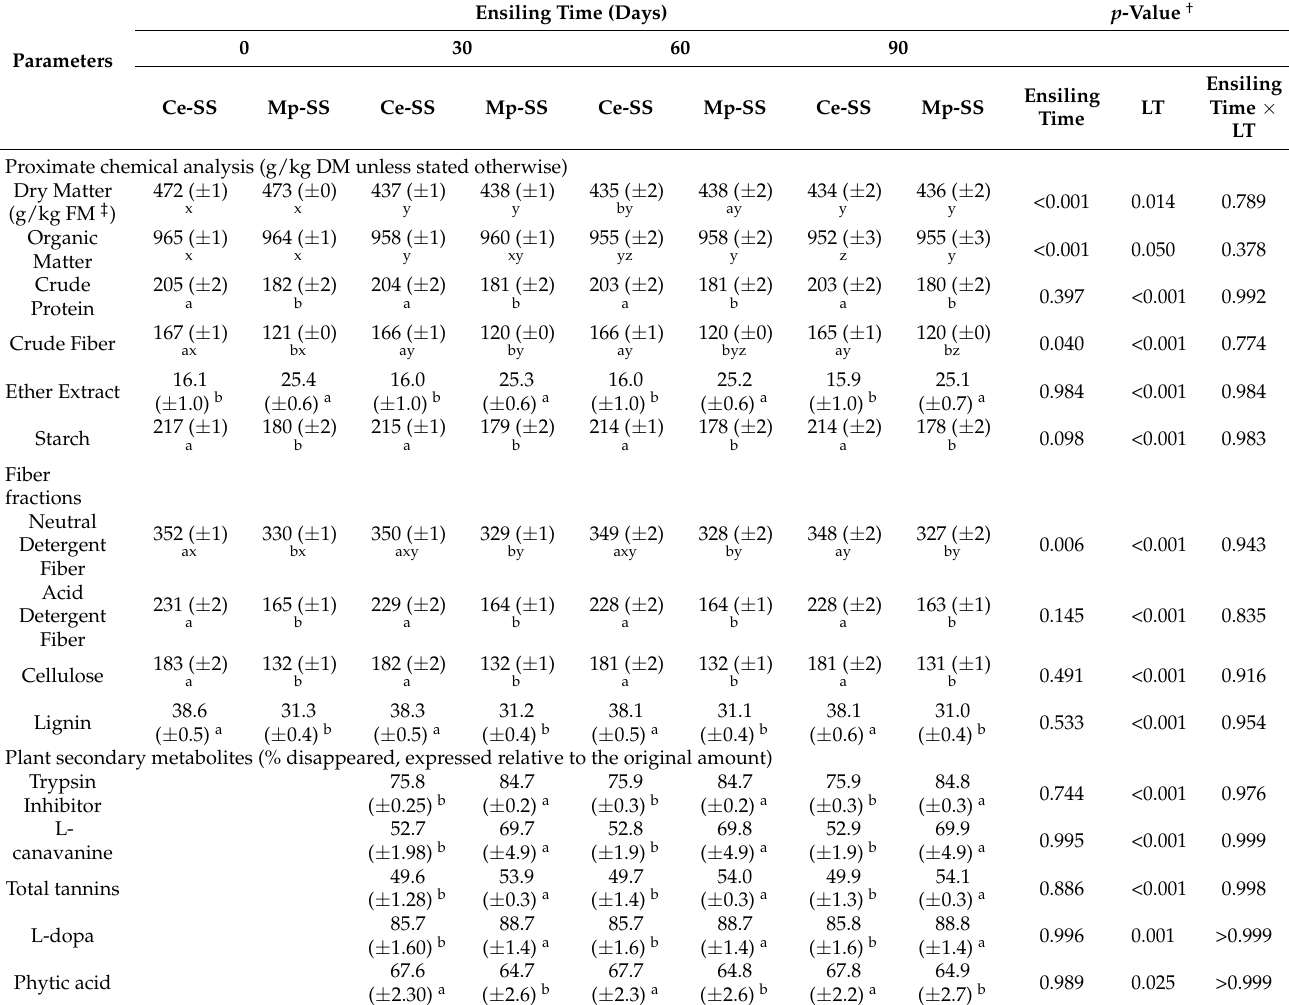
Means with different superscript ( a,b ) in the same row show statistical differences between the tropical legume inside of each ensiling time to p < 0.05 [35]. Different superscripts ( x,y,z ) in the same row and within each tropical legume indicate significant differences ( p < 0.05) according to Tukey [35]. † refers to the statistical significance according to the general linear model of SPSS [34]; LT : legume type. ‡ FM: fresh matter. Plant secondary metabolites (g/kg DM unless stated otherwise) at 0 d (TI [TIU/kg DM], L-canavanine, Total tannins, L-dopa, and Phytic acid: C. ensiformis –sugarcane silage: 132.6, 24.6, 5.4, 15.3, and 11.0 respectively; M. pruriens –sugarcane silage: 136.2, 9.8, 46.4, 29.9, and 11.6,